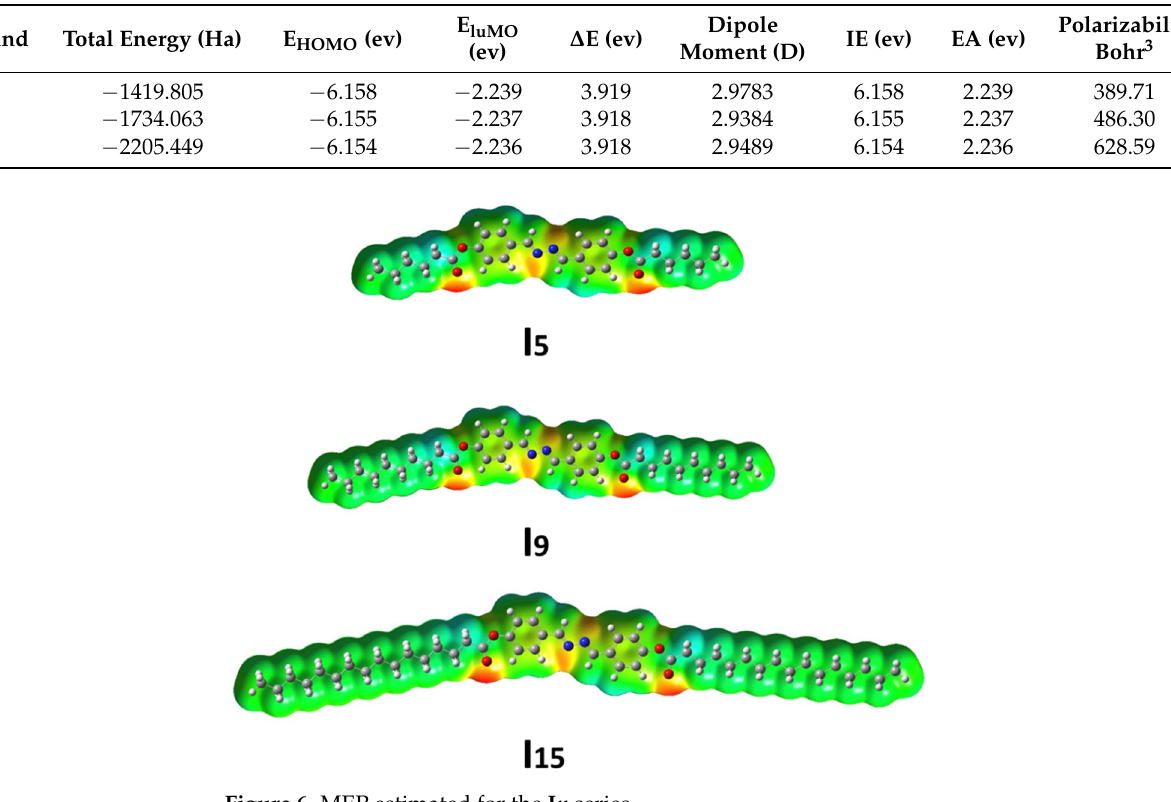
Figure 6. MEP estimated for the I n series.